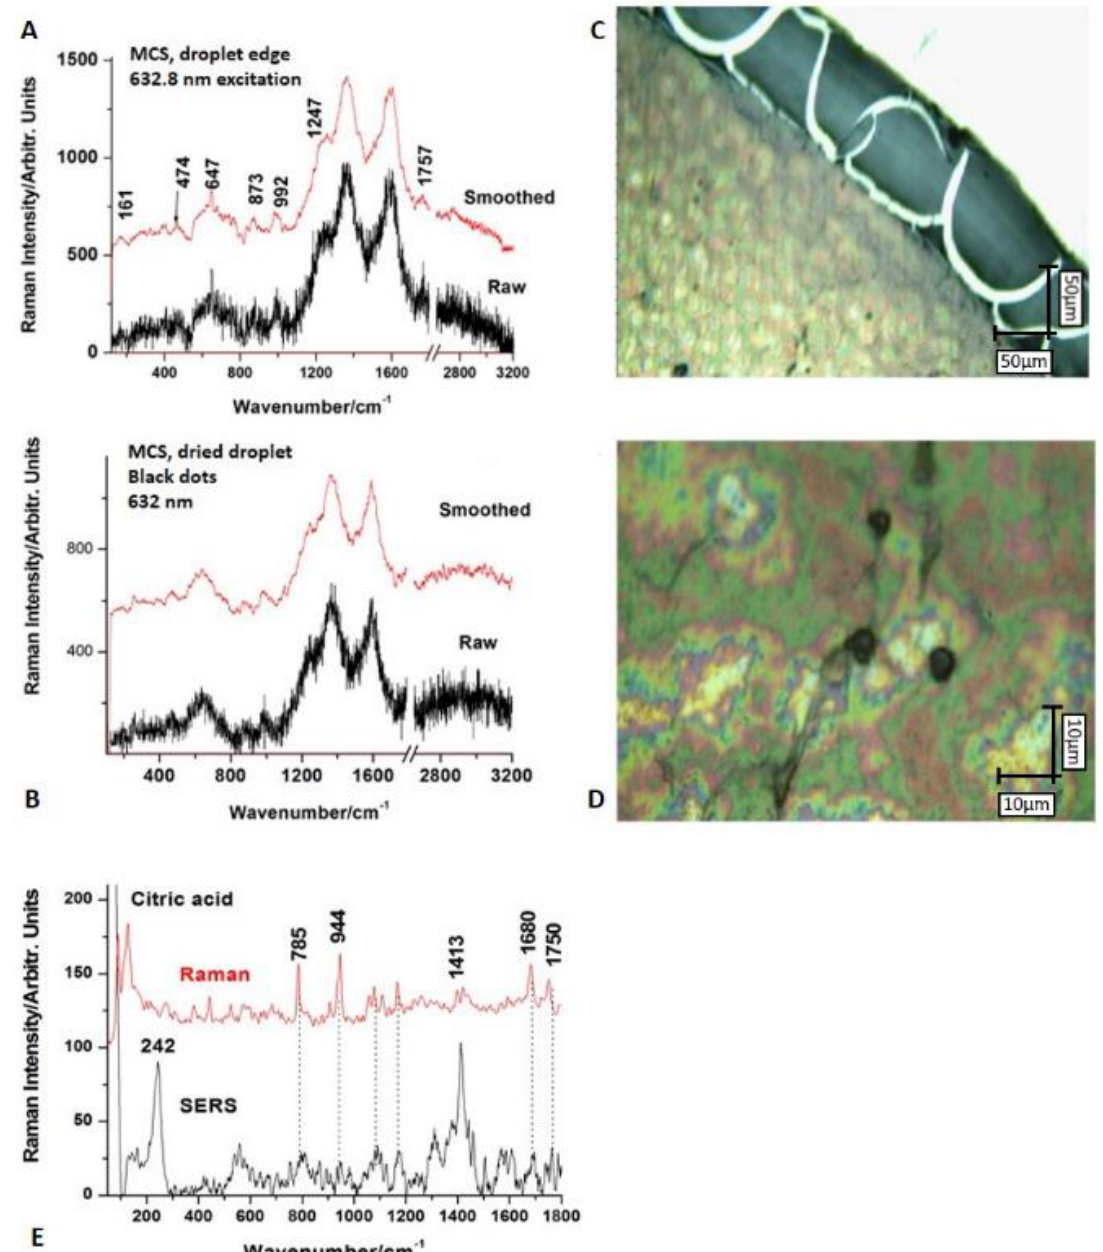
Figure 5. Typical Raman spectra collected from MCS ( A ) and black MIONP aggregates from the droplet ( B ) the light deposits also revealed amorphous carbon signals. Excitation: 632 nm. The droplet edge and center under light microscopy are highlighted in micrographs ( C ) and ( D ), respectively. Scale bar 50 µm ( C ) and 10 µm ( D ). ( E ) SERS signal recorded from a drop-coated deposition of MCS after adding the plasmonic silver nanoparticles (AgNPs) to quench the fluorescence: clear bands characteristic of citric acid were visible; Raman spectrum of citric acid is given for comparison.